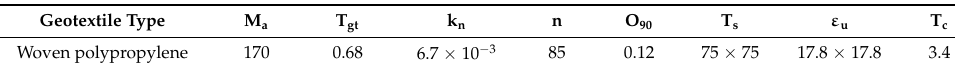
Table 1. Geotextile properties.